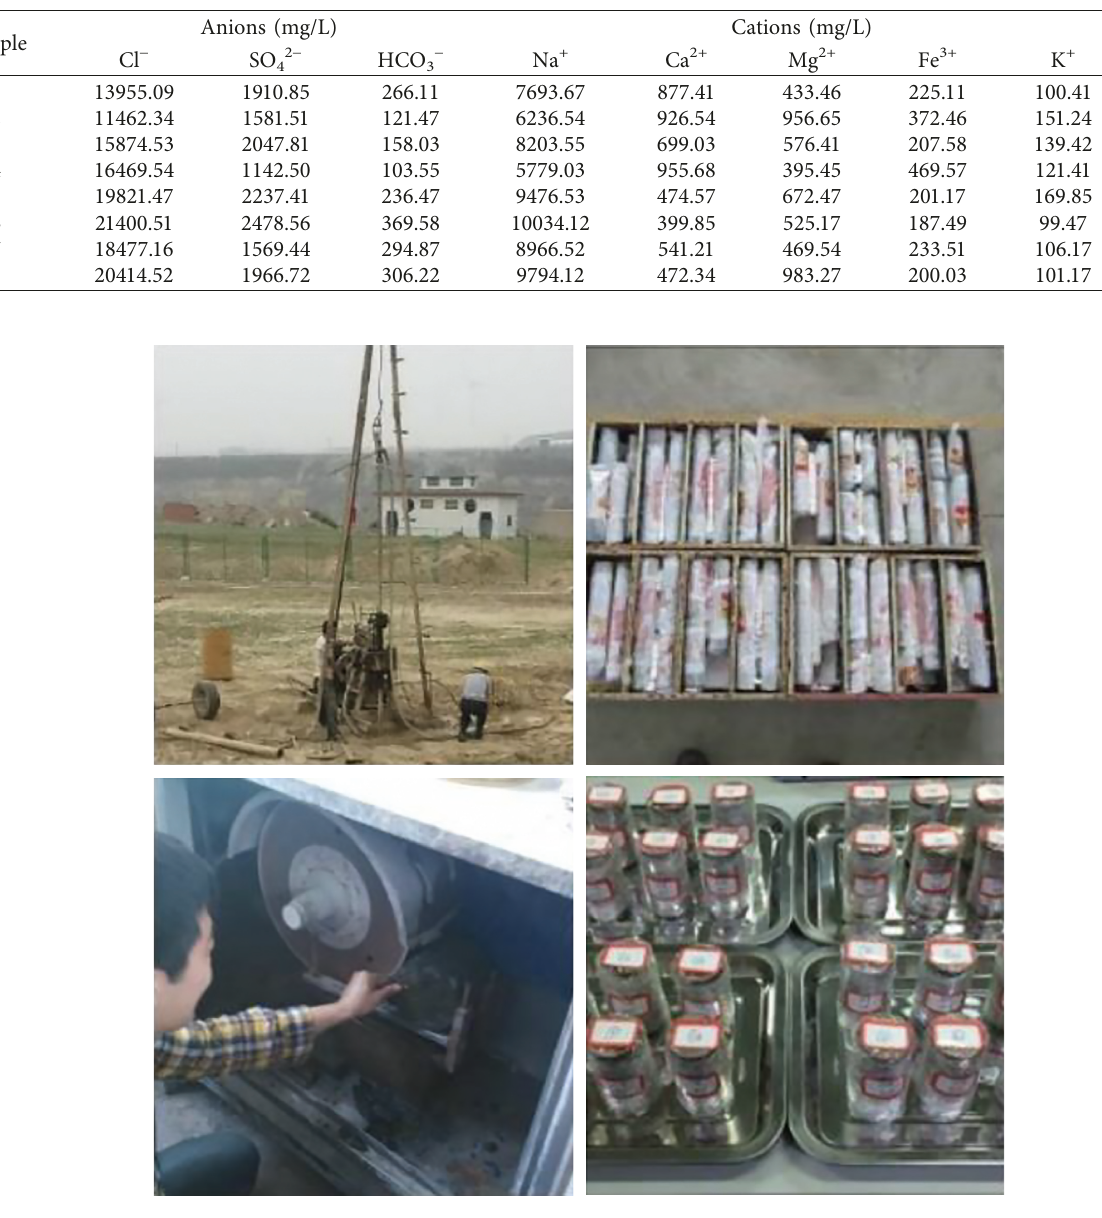
Figure 2: Preparation of rock